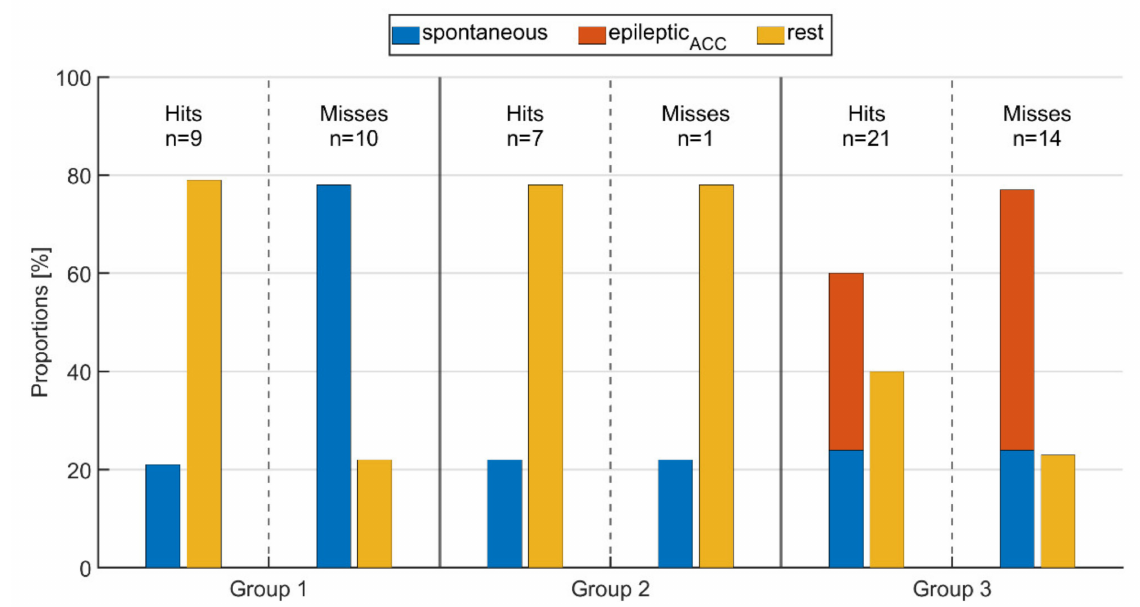
Figure 7. Proportion of spontaneous movements, epileptic movements ( epileptic ACC ), and resting phases during time intervals of (ictal or peri-ictal) tachycardia for seizures rated as either hit or miss for the respective